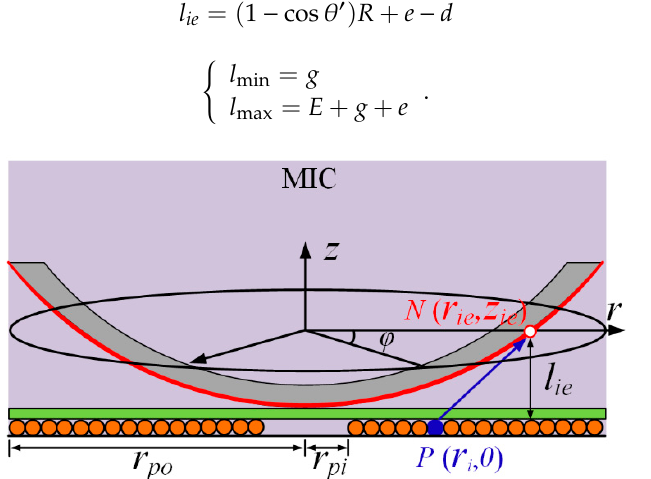
Figure 5. Wok heating using magnetic inductive coupling (MIC) without frustum coil.